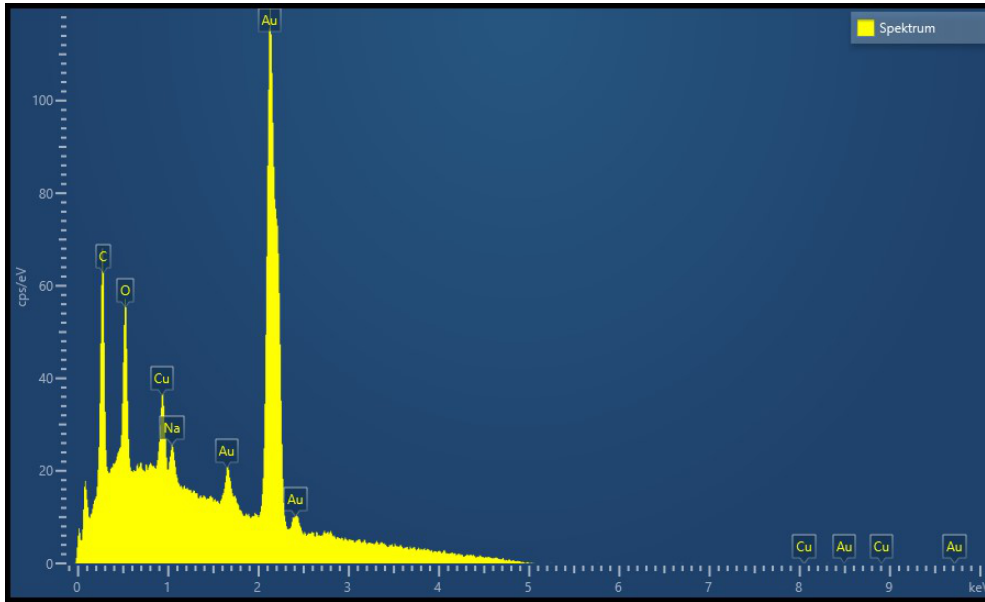
Figure 5. EDX spectrum of a single nanoparticle on the copper oxide surface at 5